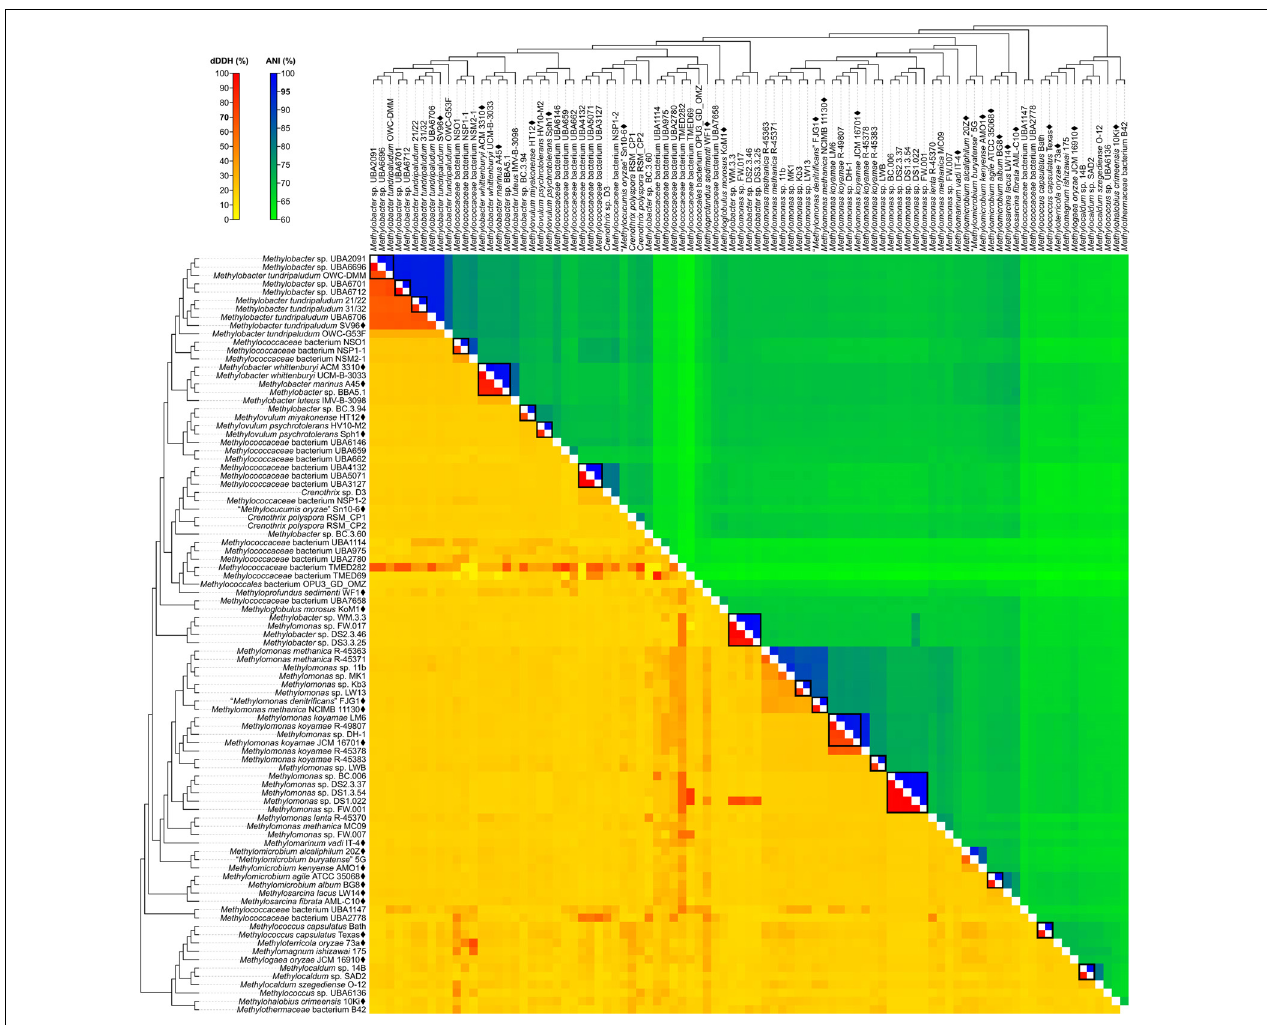
FIGURE 4 | dDDH and ANI from pairwise whole-genome comparisons. The heat map shows dDDH and ANI values between genomes, along with the tree cladogram to show relationships. Boxed regions indicate inferred species clusters with at least two members based on comparisons that are at least 70% dDDH and 95% ANI, as well as monophyly in the genome-based